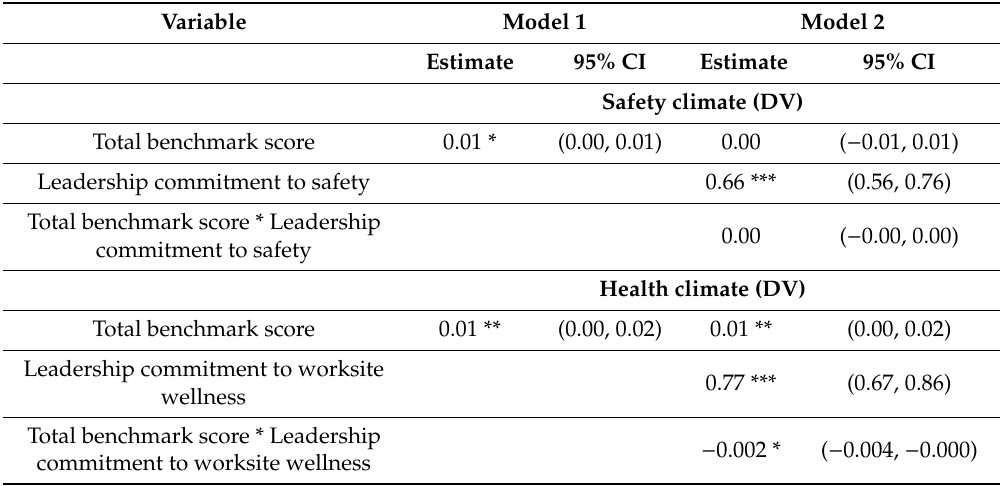
Table 4. Linear mixed model comparing the relationship between total benchmark score (IV) and safety climate/health climates (DVs) as well as the moderating effect of leadership commitment to safety/worksite wellness.